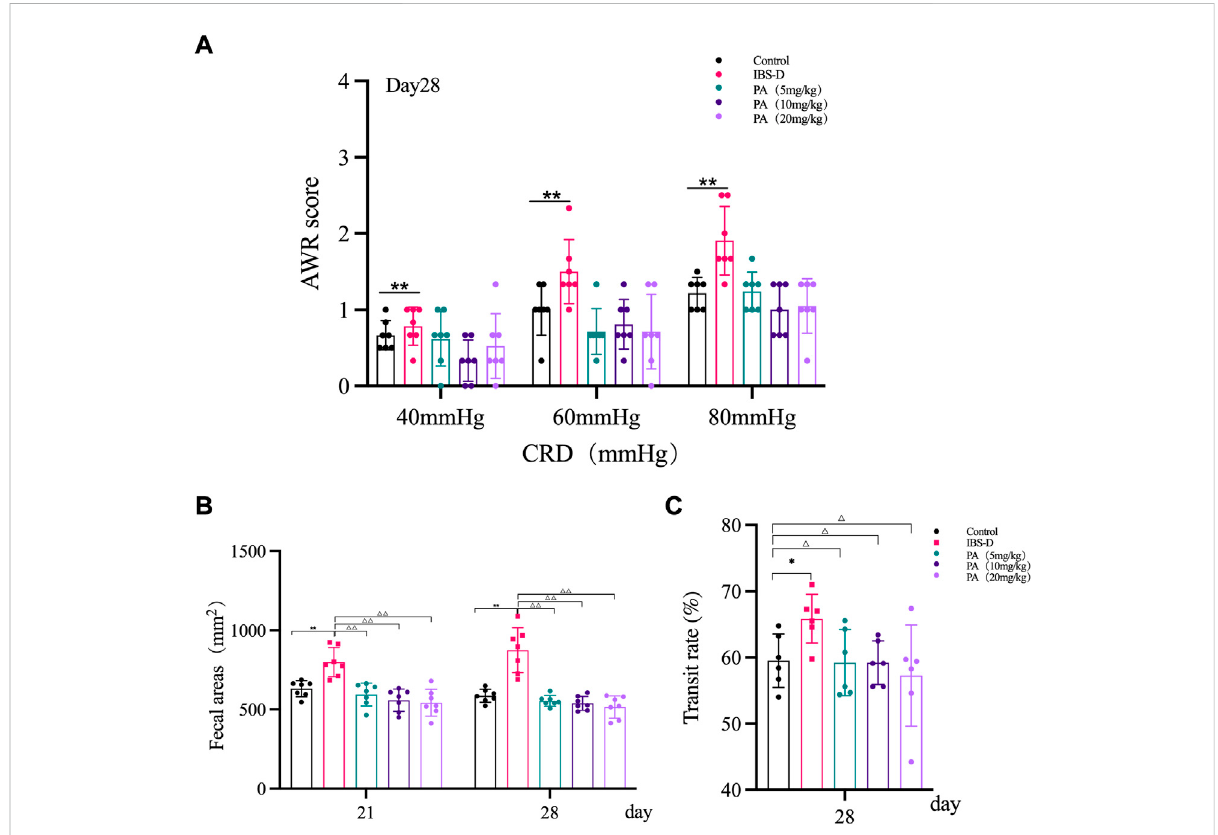
FIGURE 2 Effects of patchouli alcohol (PA) in IBS-D rats. (A) Abdominal withdrawal re fl ex assessment in different groups after PA. The AWR scores were used to assess visceral sensitivity at day 21 and day 28 after PA. (B) The defecation area evaluated diarrhea symptoms at day 7and day 14 after PA. (C) The intestinal transitrate revealed thechangesin colonmotilityamong PAgroups. Data arepresentedas mean ±SD ( n =6).* p < 0.05, ** p < 0.01, vs. controls; △ p < 0.05, △△ p < 0.01, vs.